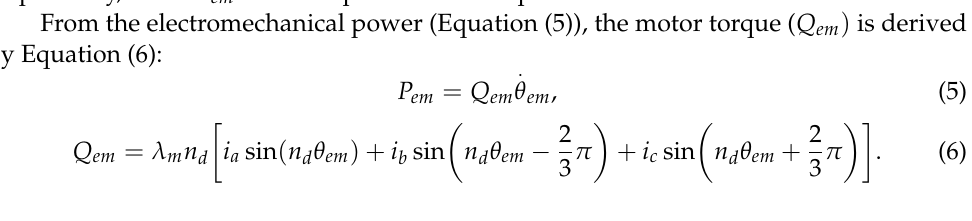
Table 1. Failure rates for PMSM faults [6].